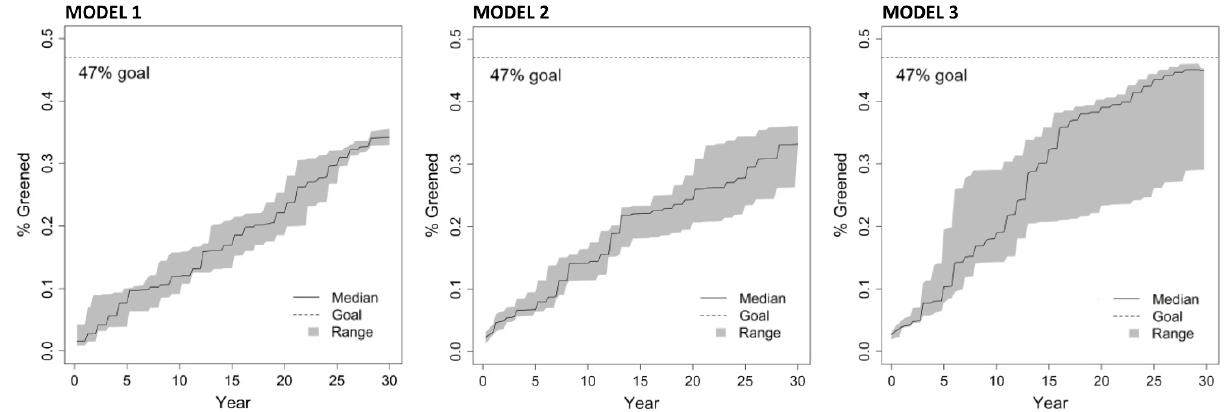
Figure 10. Results of model runs in terms of greened acres over time.